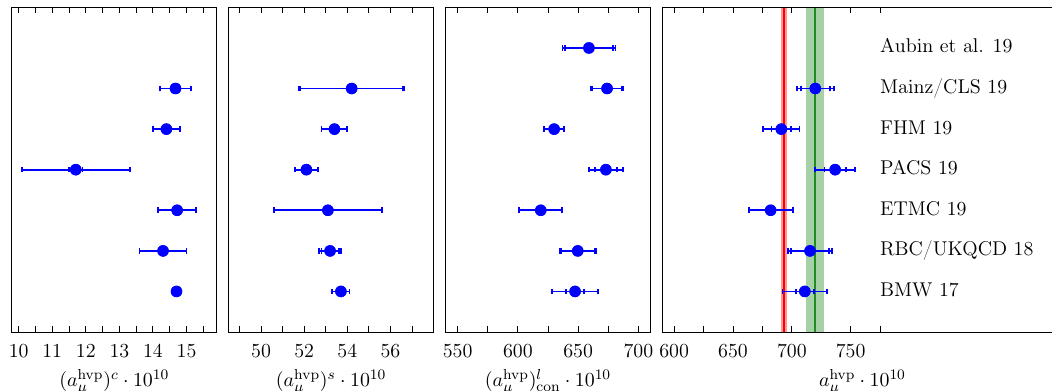
Figure 8. Recent results for the hadronic vacuum polarisation contribution from Aubin et al. [64], Mainz / CLS [26], Fermi- lab / HPQCD / MILC (FHM) [63, 65, 66], PACS [62], ETMC [48, 67, 68], RBC / UKQCD [49] and BMW [50]. From left to right the panel represent the charm, strange, light (connected) and total contributions to a hvp µ . The vertical red line indicates the result from the data-driven analysis of Ref. [7]. The green vertical band corresponds to the “no new physics” scenario.